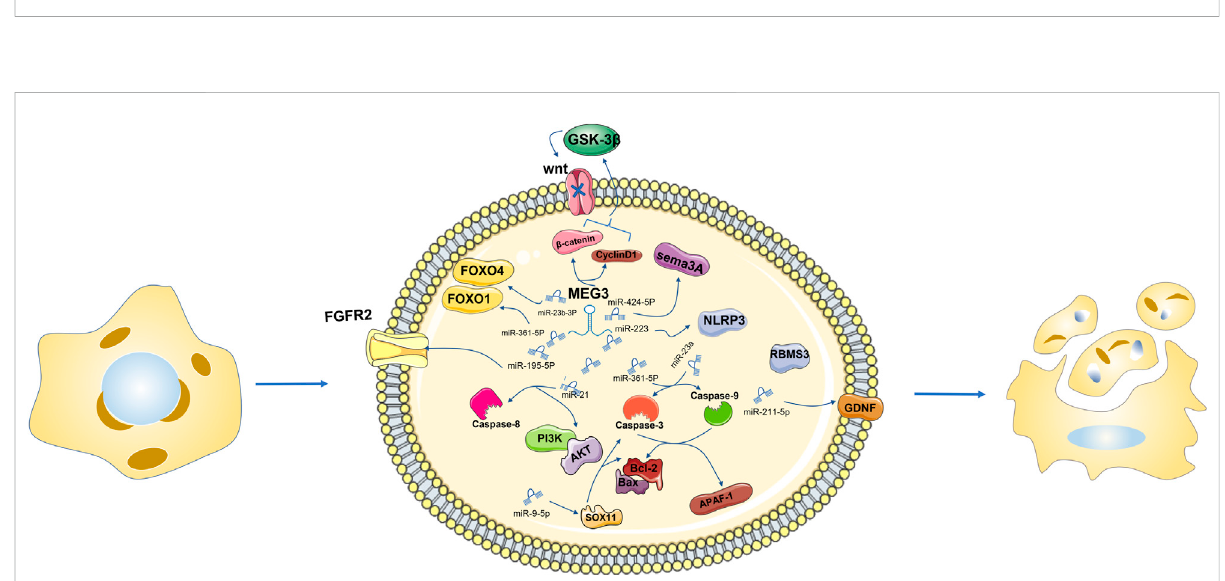
FIGURE 2 Downregulation of MEG3 can directly or through miR-361-5p mediate the downregulation of FOXO1, promote cell apoptosis, negatively regulate the expression level of miR-23b 3p, and negatively regulate the expression level of FOXO4 in the same family to promote cell apoptosis. MEG3 recovery can reduce β -catenin and CyclinD1, improve the level of GSK-3 β in vitro culture, block the activity of the Wnt signaling pathway, and then inhibit cell proliferation, migration and invasion, triggering cell